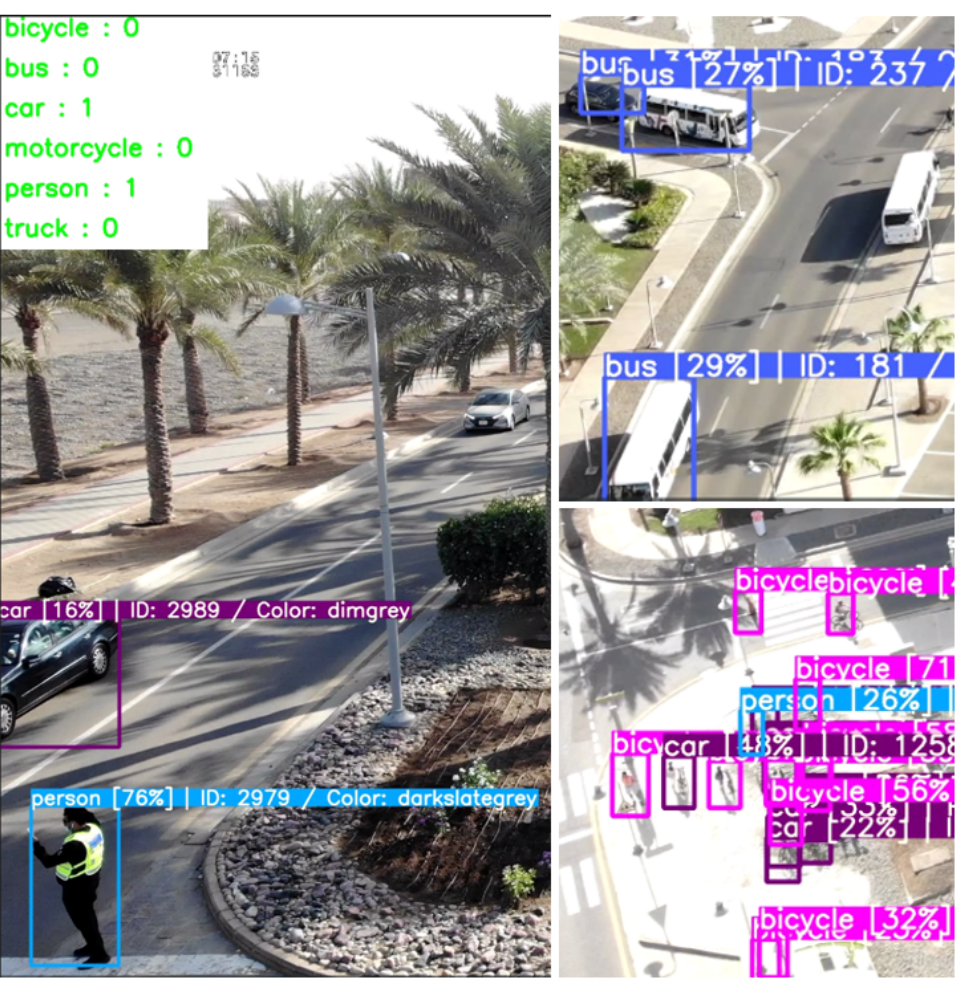
Figure 6. Close view of a sample of the output videos showing various classes, and some false negative and false positive